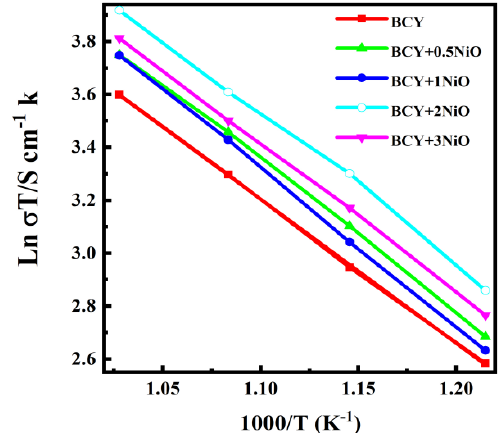
Figure 6. Arrhenius plots of the conductivity of BCY–NiO composite electrolytes in the temperature range from 550 ℃ to 700 ℃ .